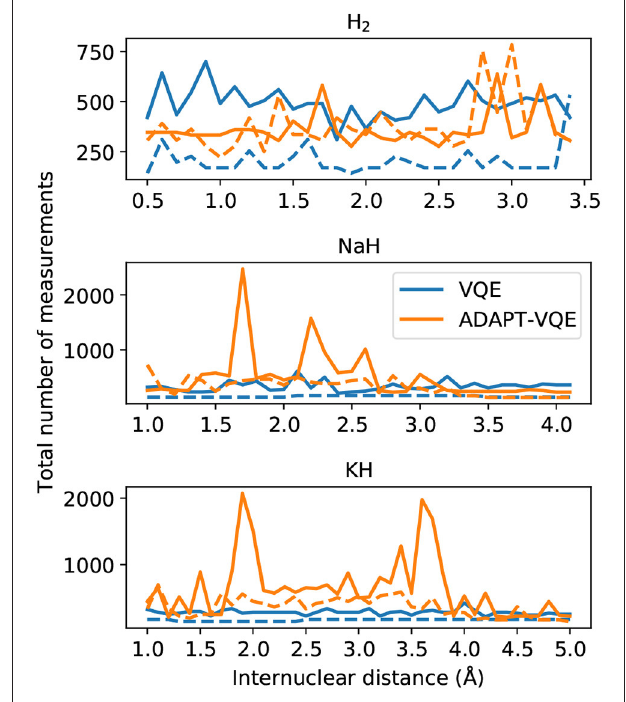
FIGURE 11 | Total number of measurements for final energy evaluation for the VQE and ADAPT-VQE ansatze using the COBYLA (solid line) and L-BFGS (dashed line)